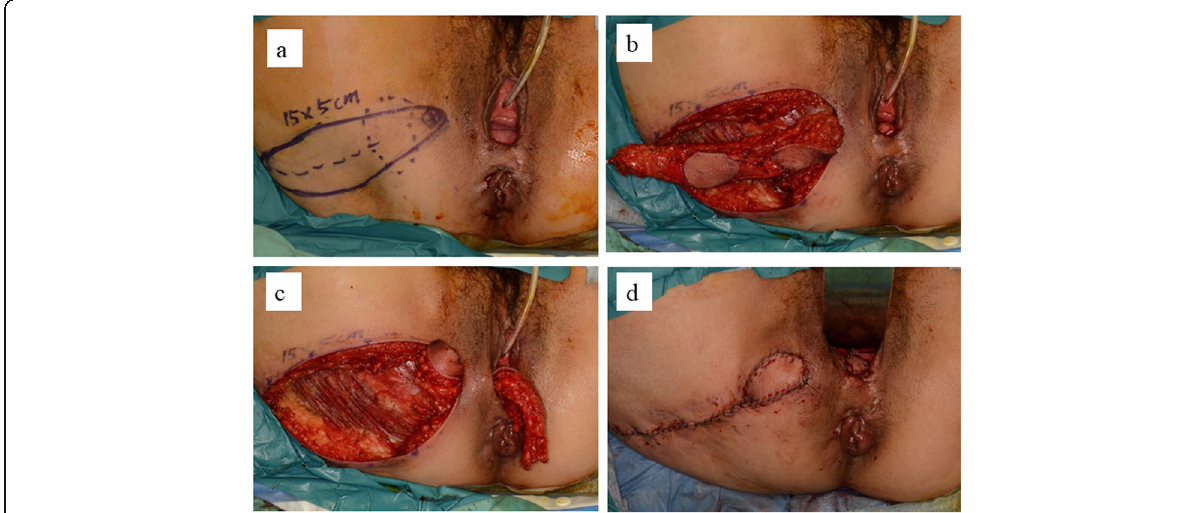
Fig. 2 Intraoperative views of the gluteal fold flap. a Perforator vessels of the internal pudendal artery are identified with a Doppler probe and marked on the medial point of the right ischial tubercle. A 5 × 15 cm diamond-shaped flap of skin, subcutaneous fat, and superficial fascia is designed. b Perforators of the internal pudendal artery in the fatty tissue act as a pedicle and provide skin flap circulation. c The gluteal-fold flap is rotated counter-clockwise through a subcutaneous tunnel and placed in the space above the rectal wall. d The donor site is closed and the skin flap is sutured to the vaginal wall defect. The skin flap is observed in the vaginal